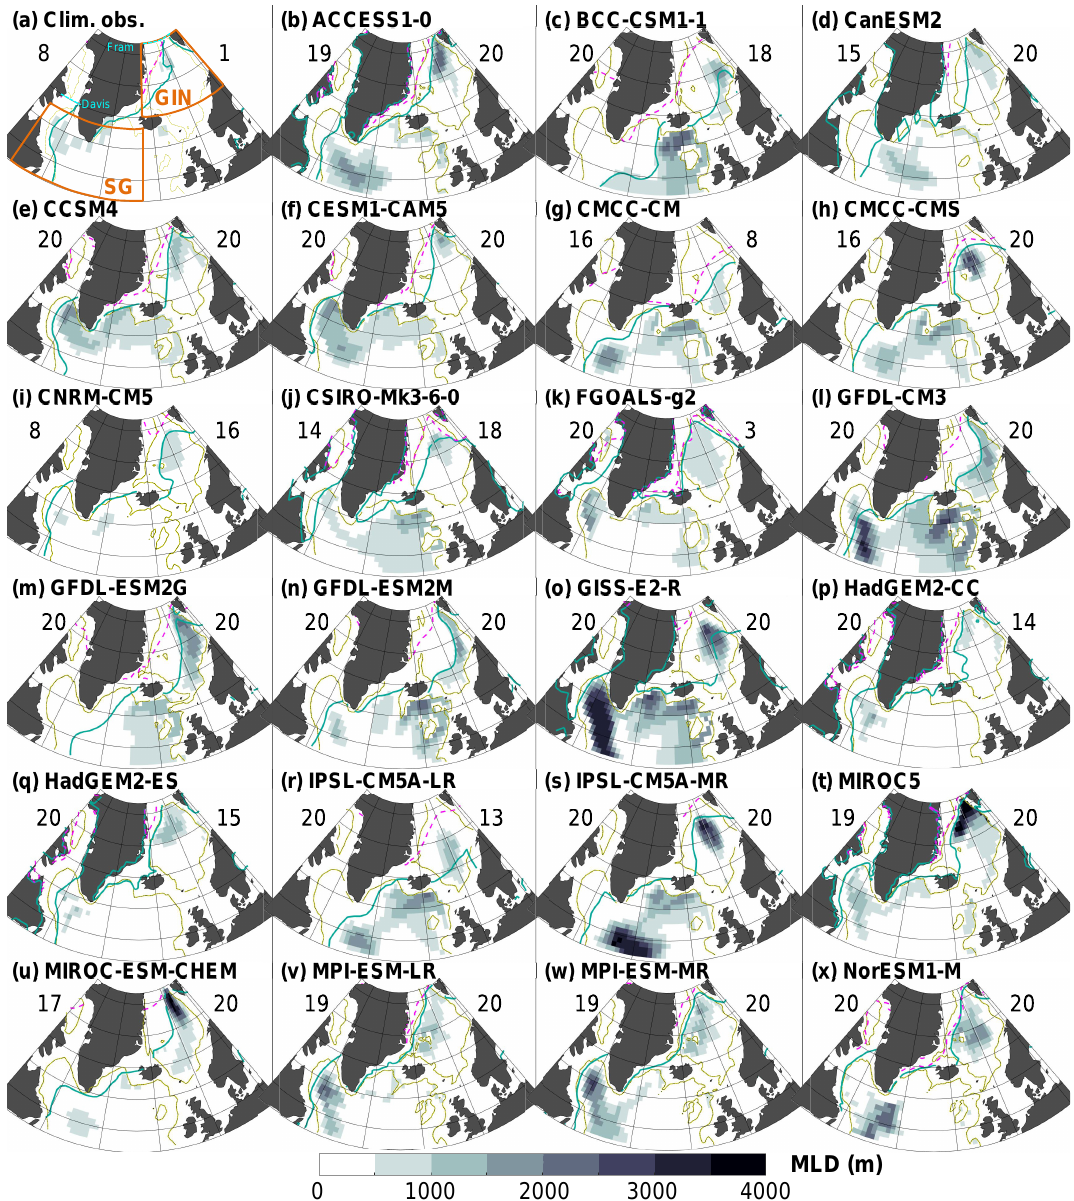
Figure 1. North Atlantic (a) climatological mixed layer depth of de Boyer Montégut et al. (2004) and (b–x) mean 1986–2005 winter MLD in the CMIP5 historical run. Orange boxes on (a) show the subpolar gyre (SG) and Greenland–Iceland–Norwegian (GIN) seas regions as defined in this study; cyan dashed lines are the Davis and Fram straits. Yellow dotted line on each panel indicates the 1000m isobath; blueish green and magenta lines denote the mean March and September sea ice extent, respectively. Left number is the number of years, out of 20, with deep convection in SG; right number is deep convection in